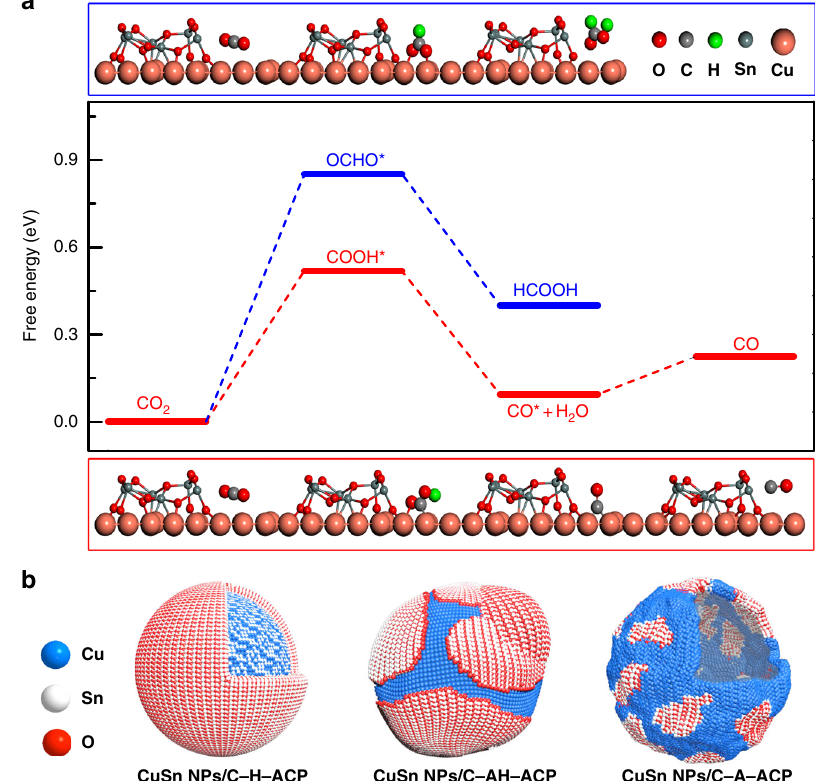
Fig. 6 Density functional theory simulations of the CO 2 reduction reaction on Cu/SnO 2 interfaces. a Free energy pro fi les of two pathways for CO 2 electroreduction on Cu/SnO 2 interfaces. The upper and lower images are optimized geometric structures of various states (COOH*, OCHO*, and CO*) of the process on Cu/SnO 2 interfaces, respectively. H, C, O, Cu, and Sn atoms are represented by green, gray, red, reddish brown, and dark gray spheres, respectively. b The models of CuSn NPs/C-A-ACP, CuSn NPs/C-H-ACP, and CuSn NPs/C-AH-ACP with different Cu/SnO 2